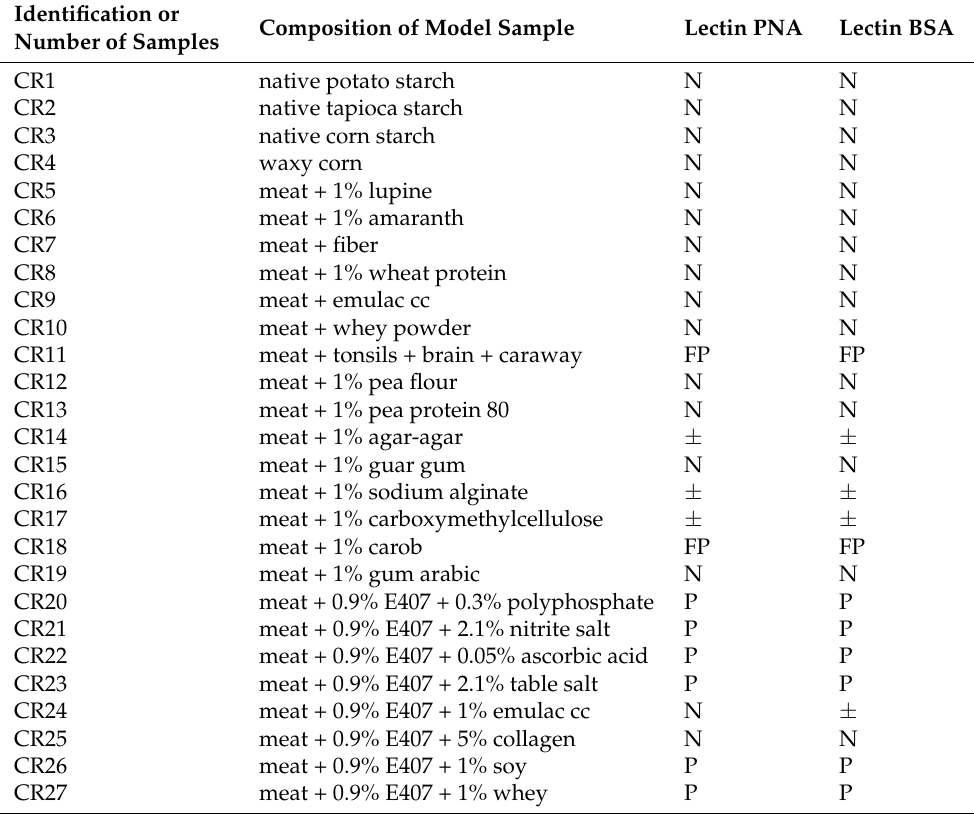
Table 4. Results of cross-reactivity for raw